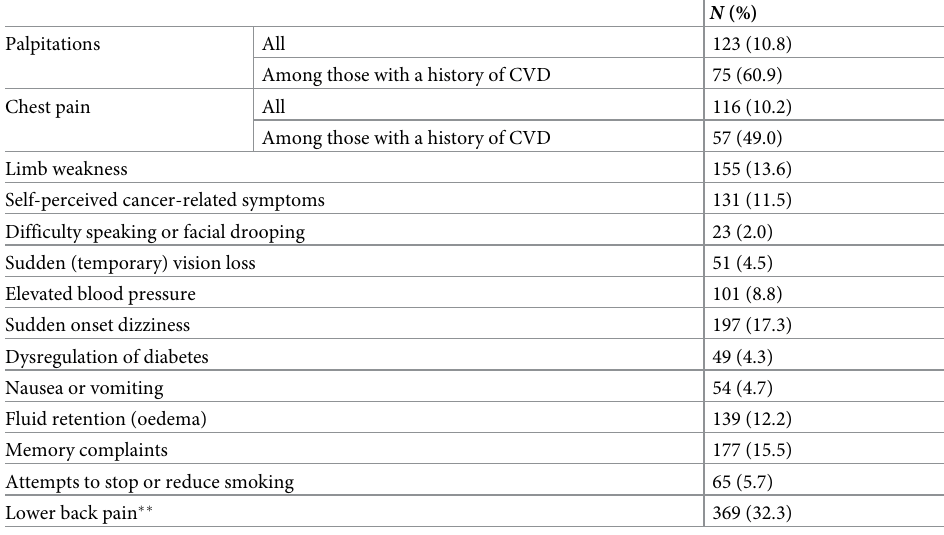
Table 2. Symptoms for which healthcare was avoided ( N = 1,142) �